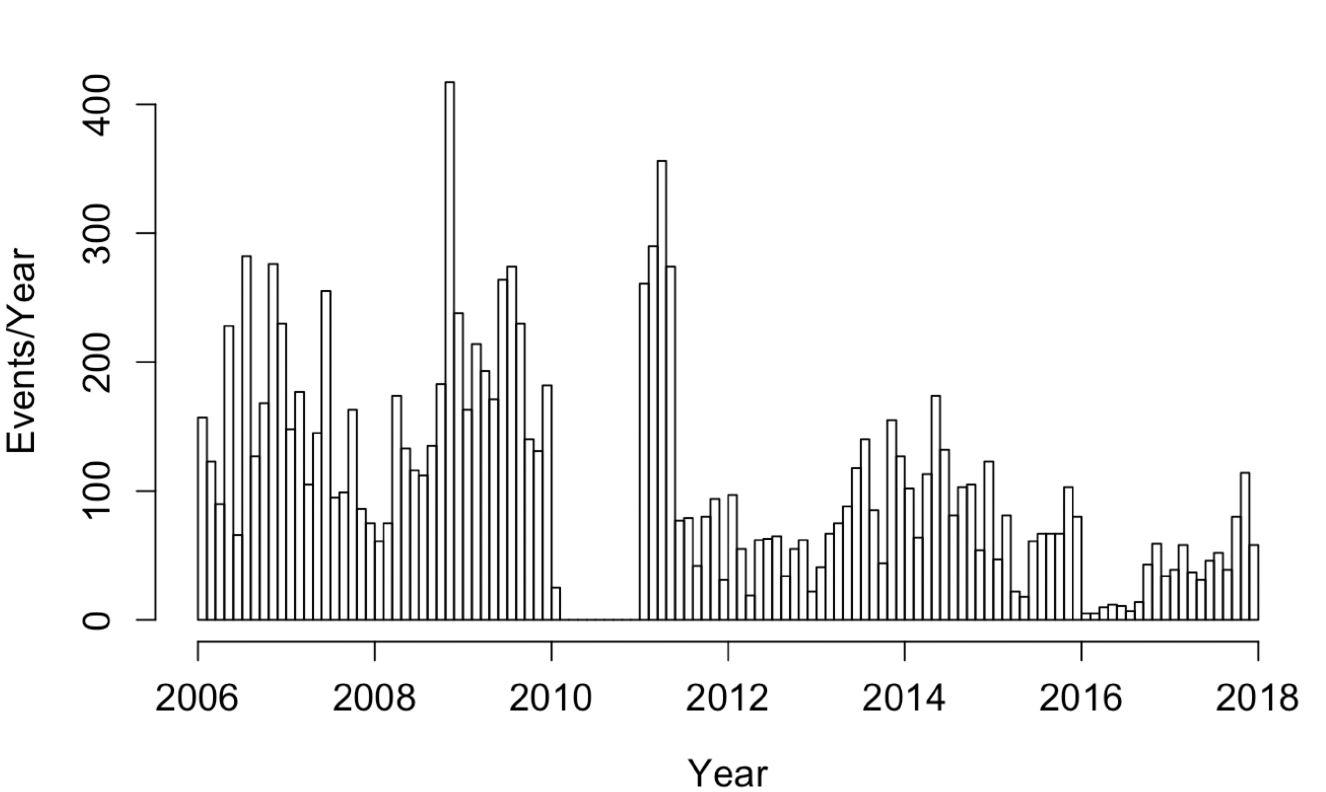
Figure 1. Histogram of coccidioidomycosis cases in California from January 2006 to December